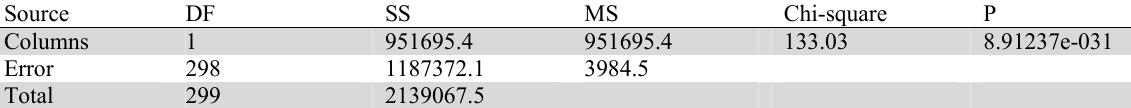
Results of Kruskal-Wallis Test for Comparison between PSO & IWO Source DF SS MS Columns